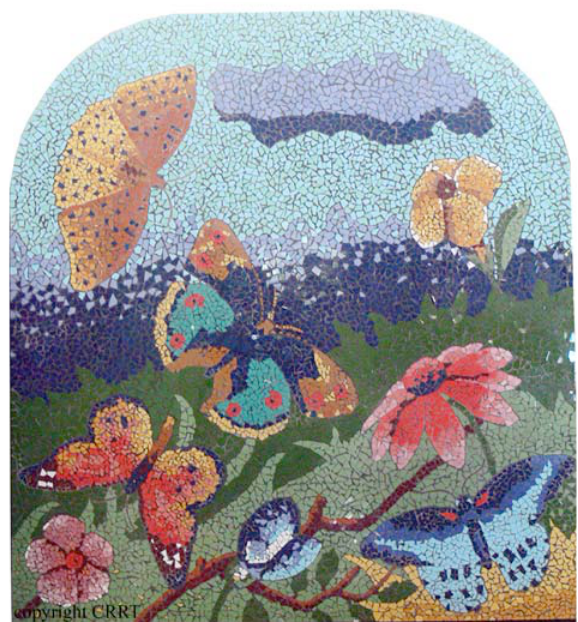
Image 14. Mosaic panel - one panel from a set of three depicting butterflies of the southern Coromandel Coast. Species represented: Common Leopard Phalanta phalantha , Blue Pansy Junonia orithya , Plain Tiger Danaus chrysippus and Blue Mormon Papilio polymnester . Tholkappia Poonga, Chennai.